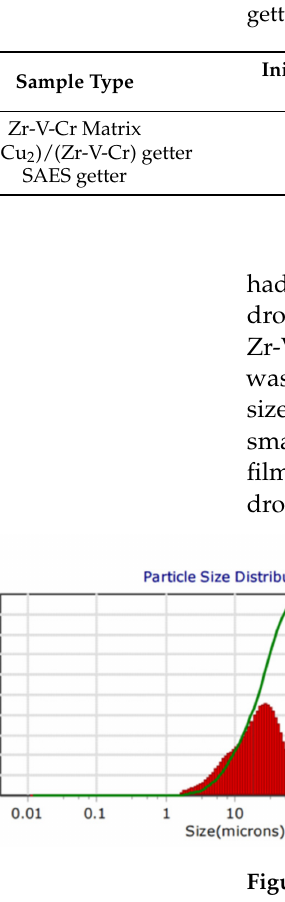
Figure 6. Laser particle size curves analysis of Zr-V-Cr matrix powder ( a ) and Zr 98 Cu 2 slurry powder ( b